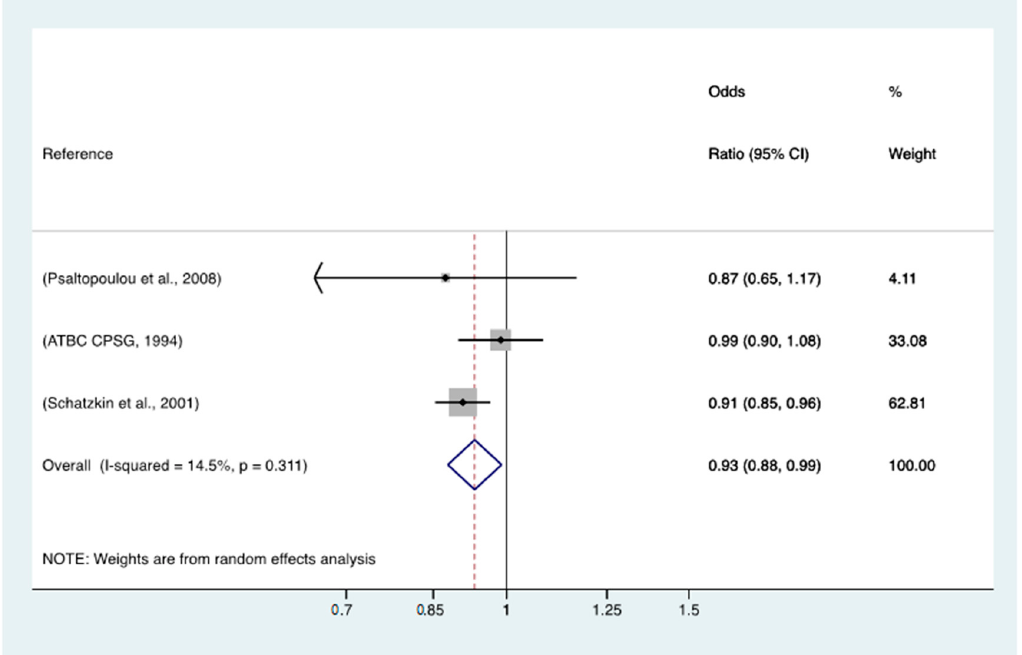
Figure 2. Results of the meta-analysis restricted to the cohort studies included. Notes: ATBC CPSG = The alpha-tocopherol beta carotene Cancer Prevention Study Group. Meta-analysis of the results for portions of yoghurt intake per week is continuous [17,18,32].